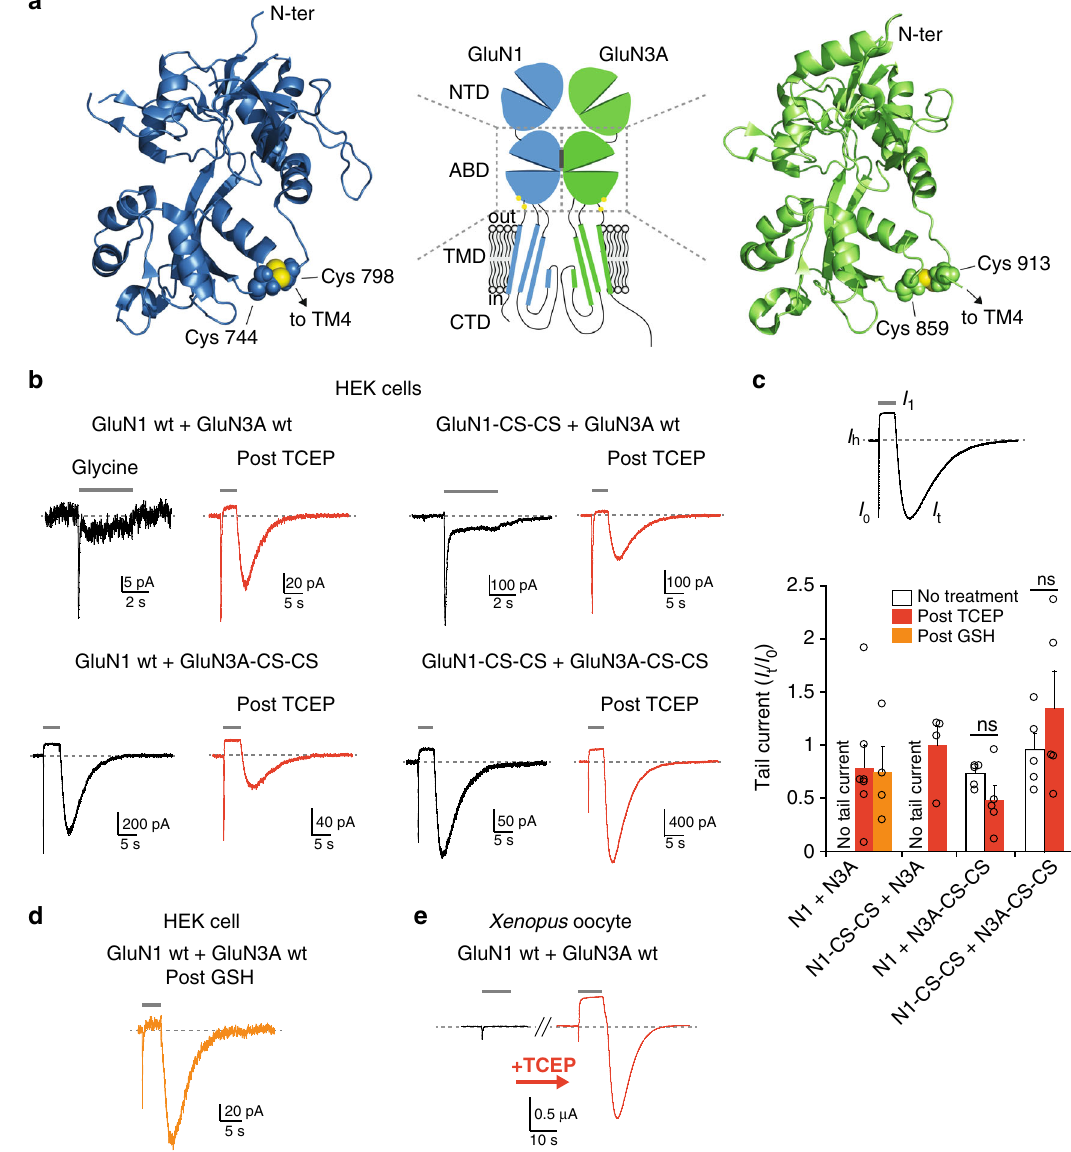
Fig. 3 GluN1/GluN3A receptors display strong redox sensitivity. a Structure of the GluN1 and GluN3A ABDs (PDB 4KCC and 4KCD, respectively 55 ). Cysteines involved in endogenous redox-sensitive disul fi de bridges are highlighted (sulfur atoms shown in yellow). The central cartoon illustrates domain organization in GluN1/GluN3A receptors; NTD, N-terminal domain; ABD, agonist-binding domain; TMD, transmembrane domain; CTD, C-terminal domain. b Effect of TCEP treatment (5 mM, 20 min) on wild-type and mutant GluN1/GluN3A receptors expressed in HEK 293 cells. Glycine was applied at 100 µ M. Each trace comes from a separate cell. c Quanti fi cation of tail currents observed upon washout of glycine on wild-type and mutant GluN1/GluN3A receptors. Inset indicates current tags used for quanti fi cation. n.s. P = 0.125 and 0.337, Student ’ s t -test ( n = 4 – 9). Note that non-treated receptors containing wild-type GluN3A subunits do not exhibit tail currents. Data are mean ± SEM. d Effect of reduced glutathione (GSH, 50 mM for 20 min) on wild- type GluN1/GluN3A receptors expressed in HEK293 cells. Glycine was applied at 100 µ M. e Effect of TCEP treatment (5 mM, 20 min) on wild-type GluN1/ GluN3A receptors expressed in Xenopus oocytes. The pair of current traces corresponds to responses before and after TCEP treatment on the same cell. Glycine was applied at 100 µ